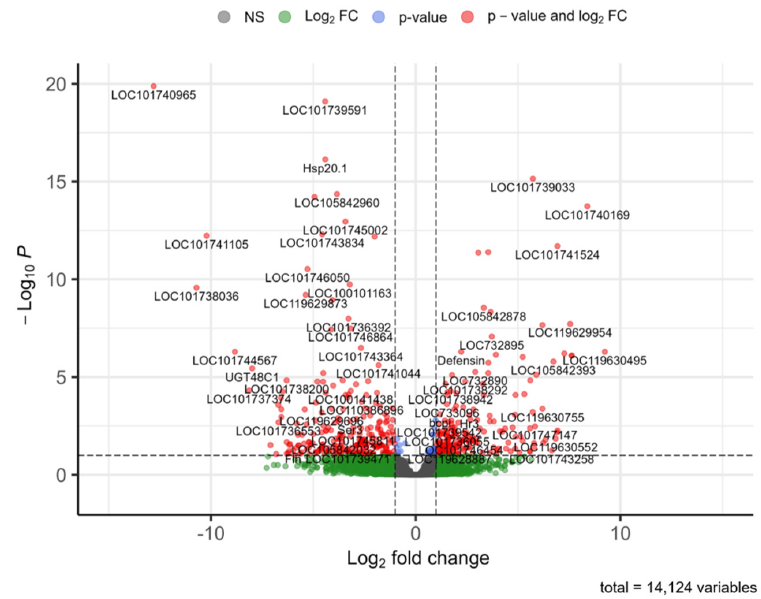
Figure 7. Volcano plot of DEGs from Bombyx mori , log fold change vs. − log P . Gray: Nonsignificant genes; green: Genes with significant fold changes but insignificant adjusted p -values; blue: Genes that passed the significance threshold according to adjusted p -value but did not have significant fold changes; red: Genes that have adjusted p -value < 0.1 and significant fold change (|log 2 FC| > 1). Graph generated in R package EnhancedVolcano [28]. Table 6. Summary of select top DEGs between different Bombyx mori strains (CAR vs. TCMO). Downregulated Genes (CAR vs.